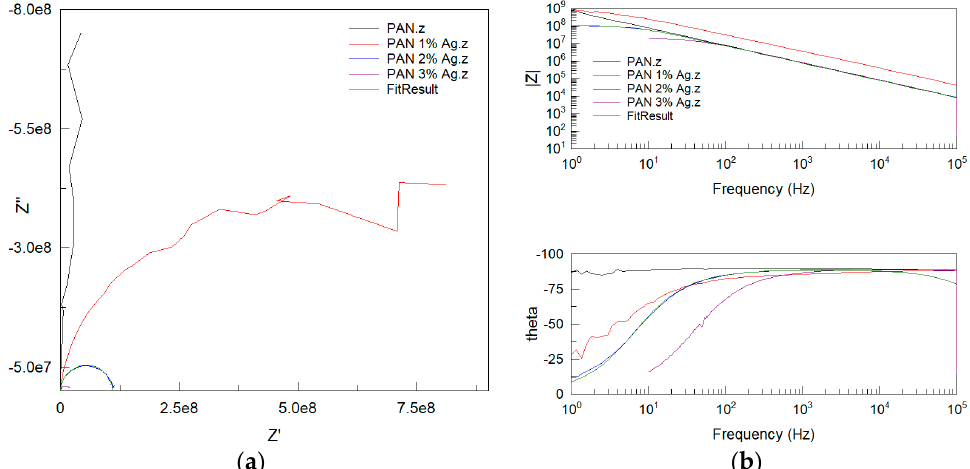
Figure 7. Nyquist diagram of fibers. Nyquist ( a ) and Bode ( b ) plots of fibers. The fitting result is shown for the PAN 2% Ag fiber.